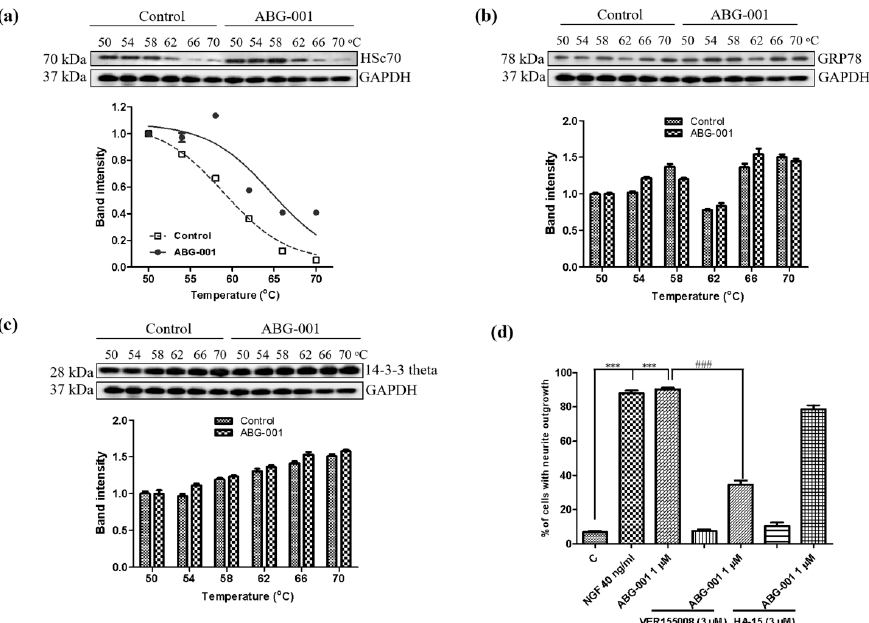
Figure 4. Target confirmation by CETSA and inhibitor analysis. ( a – c ) CETSA of PC12 cells on Hsc70, GRP78, and 14-3-3 theta protein and corresponding fitting curves. ( d ) Effect of Hsc70 (VER155008) and GRP78 (HA-15) inhibitors on the neurite outgrowth induced by ABG-001. *** indicate significant differences at p < 0.001 compared with the control group; ### indicate significant differences at p < 0.001 compared with the ABG-001 treated group. siRNA analysis was also used to make the confirmation to obtain additional evi- dence. The different concentrations of 5-carboxyfluorescein (FAM)-labeled siRNA (50, 100, and 150 nM) were used to validate the optimal transfection concentration of siRNA, and approximately 90% of PC12 cells produced fluorescence after treatment with 150 nM FAM-labelled siRNA. Therefore, 150 nM Hsc70 siRNA was used to perform the transfec- tion. Hsc70 siRNA was transfected into PC12 cells for 6 h and treated with 1 μ M ABG-001. After the treatment of PC12 cells with Hsc70 siRNA, the percentage of cells with neurite outgrowth induced by ABG-001 for 48 h was significantly decreased (Figure 5a,b). Be- sides, the total protein levels of Hsc70 were markedly decreased by the treatment with Hsc70 siRNA regardless of the ABG-001 treatment (Figure 5c, Supplementary Figure S5a). Hence, these results indicated that Hsc70 might be the target protein of ABG-001. 3.5. Target Identification of ABG-001 by Pull-down Assay A Pull-down assay was conducted to check the target protein to further confirm the target of ABG-001. PC12 cells were treated with negative control, ABG-P1, and ABG-PC for 4 h. The cell lysates were collected and applied to click reaction with biotin-azide. After unreacted biotin was removed, the cell lysates were incubated with streptavidin magnetic beads at 4 °C overnight. Subsequently, the beads were boiled with SDS to dissociate the bound protein and analyzed by Western blotting analysis. The Hsc70 protein was detected after binding with streptavidin magnetic beads in the ABG-P1 treated group. However, the Hsc70 protein was not detected in the control and ABG-PC treated groups. This ex- periment was repeated twice, and similar results were obtained (Figure 5d, Supplemen- tary Figure S5b). The results showed that the same bound protein Hsc70 was identified by using the ABPP assay or pull-down assay.